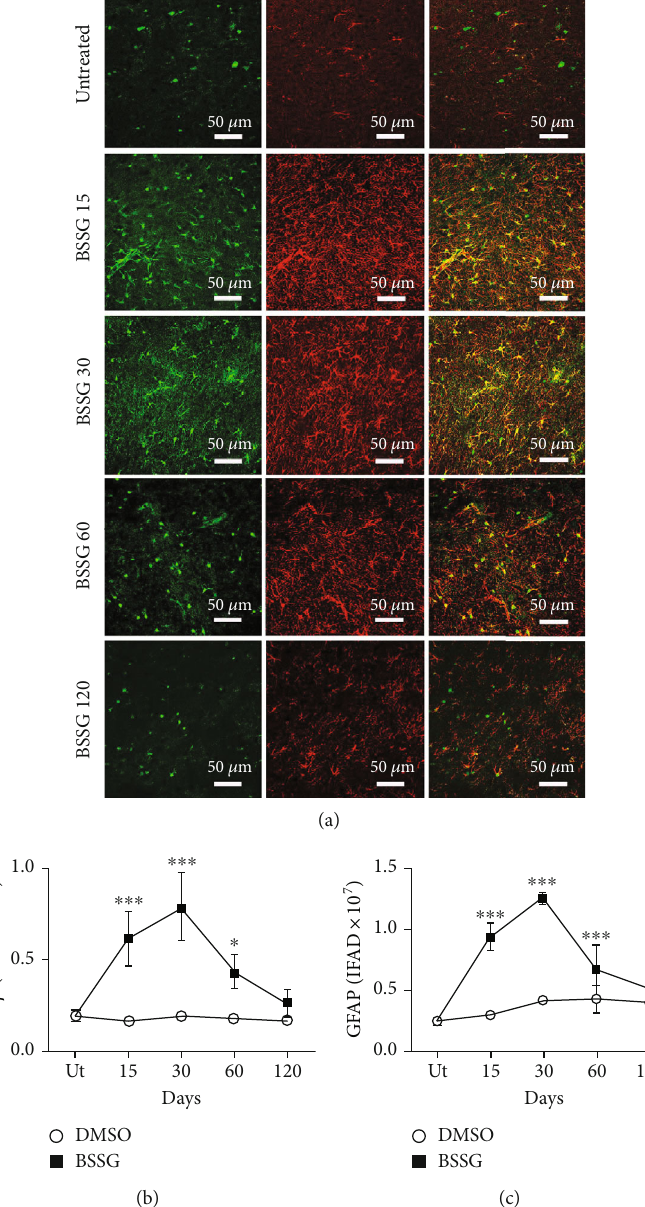
Figure 6: Colocalization of S100 β and GFAP immunoreactivity after a BSSG injection in the SNpc. (a) Representative micrographs of the double immuno fl uorescence in untreated (Ut) control rats and rats at di ff erent times (shown at the left side of micrographs) after BSSG injection. IFAD quanti fi cation for S100 β (b) and GFAP (c) during the experimental time course. The S100 β and GFAP values for the mock rats correspond to the quanti fi cation in Supplementary Figure 5. The values are the mean ± SD from four anatomical levels. n = 3 independent rats in each time of each experimental condition. Two-way ANOVA and post hoc Bonferroni tests were applied for statistical analysis. The levels of signi fi cance were ( ∗∗∗ ) P < 0 : 001 and ( ∗ ) P < 0 : 05 compared with the DMSO mock and Ut groups of the respective